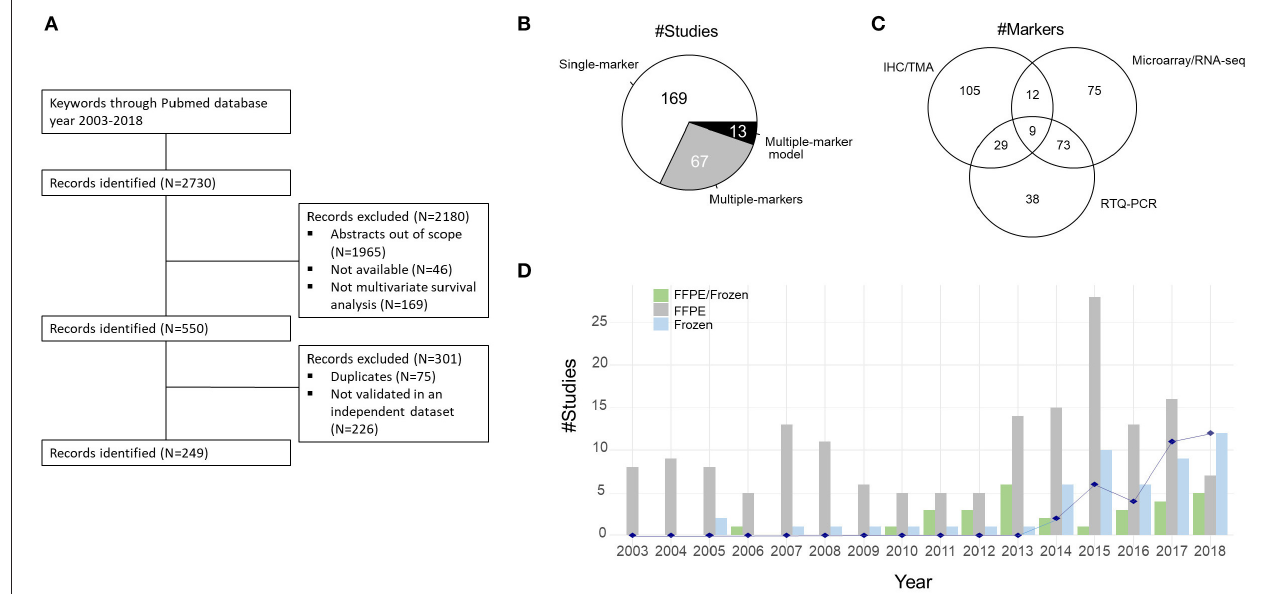
FIGURE 1 | (A) Consort diagram showing the selection process of studies included in the literature review. (B) Distribution of the studies investigating one marker, several markers, or multiple-marker models. (C) Venn diagram of the distribution of technologies used to quantify the expression level of the 341 genes. IHC, immunohistochemistry; TMA, tissue microarray; RNA-seq, RNA sequencing; RTQ-PCR, reverse-transcription quantitative polymerase chain reaction. (D) Distribution of the number of studies according to the type of biomaterial over the years: Frozen samples and/or formalin-fixed paraffin-embedded (FFPE) samples. The blue line indicates the number of studies using The Cancer Genome Atlas (TCGA) dataset as training or validation